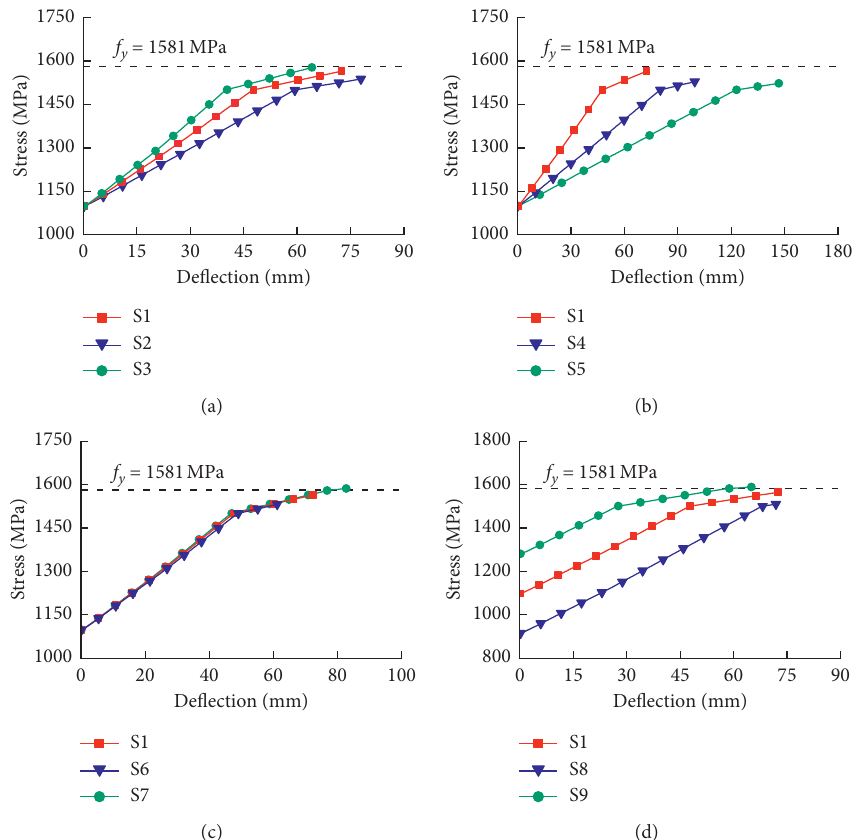
Figure 14: Stress development of UPSs. (a) Effect of CSW depth. (b) Effect of beam span. (c) Effect of concrete compressive strength. (d) Effect of initial effective